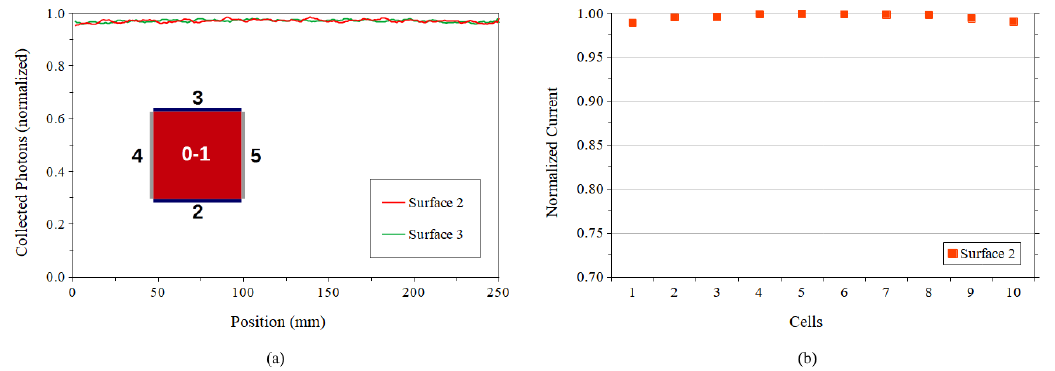
Figure 8. Unshaded LSC panel with two 10-cells PV arrays: ( a ) Normalized number of rays of light collected by the PV cells as a function of the position along the LSC side, which ranges from 0 mm to 250 mm. ( b ) Normalized current produced by each PV cell.